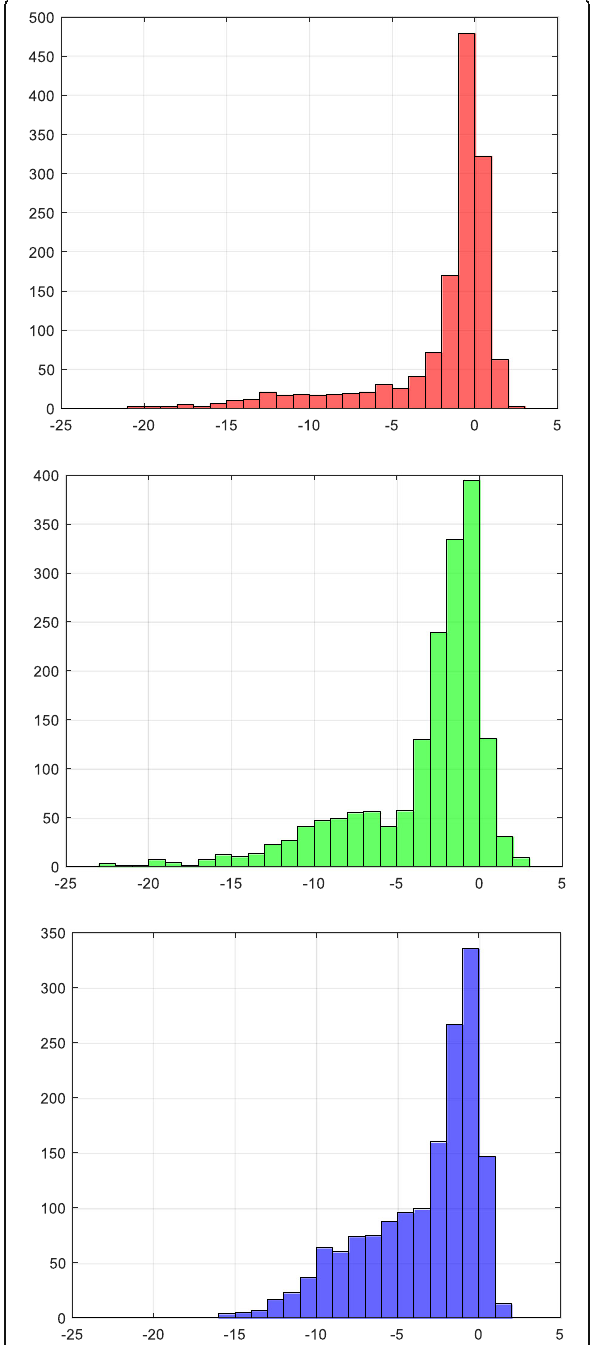
Fig. 5 Three figures correspond to three speakers. Red , green , and blue histograms represent the CLNF error of the three speakers, respectively. The abscissa is the error (larger than two pixels are considered as the mistake) and the Y -axis is the frequency of these errors